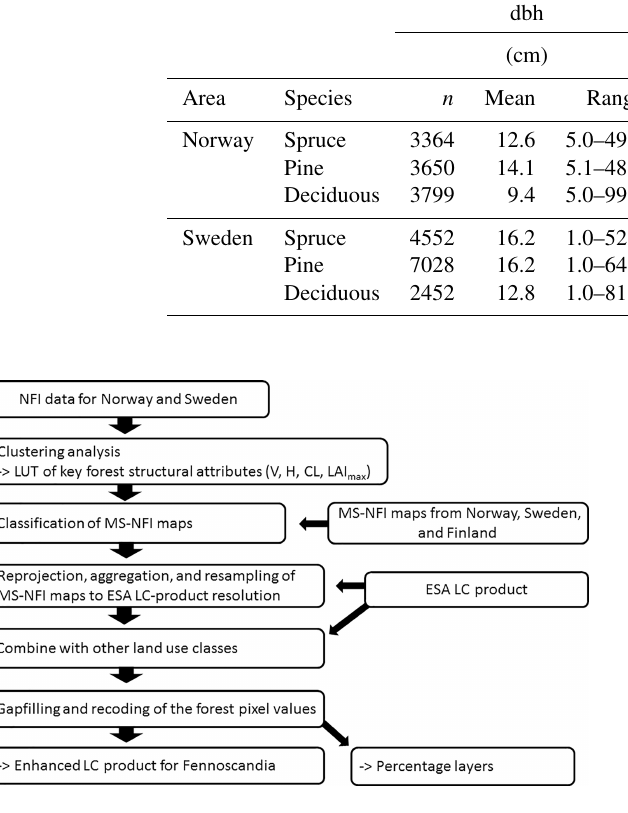
Figure 1. Flowchart for developing and applying the forest clas- sification scheme (Sects. 2.2.1 and 2.2.2). Abbreviations: Na- tional Forest Inventory (NFI), lookup table (LUT), total stem vol- ume (m 3 ha − 1 ) ( V ), Lorey’s height ( H ), crown length (CL), max- imum growing season leaf area index (LAI max ) , multisource NFI (MS-NFI; i.e., products provided by forest authorities), European Space Agency Land Cover (ESA LC)